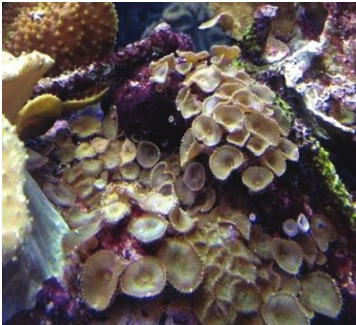
Figure 1: Coral similar to that encountered by the patient.